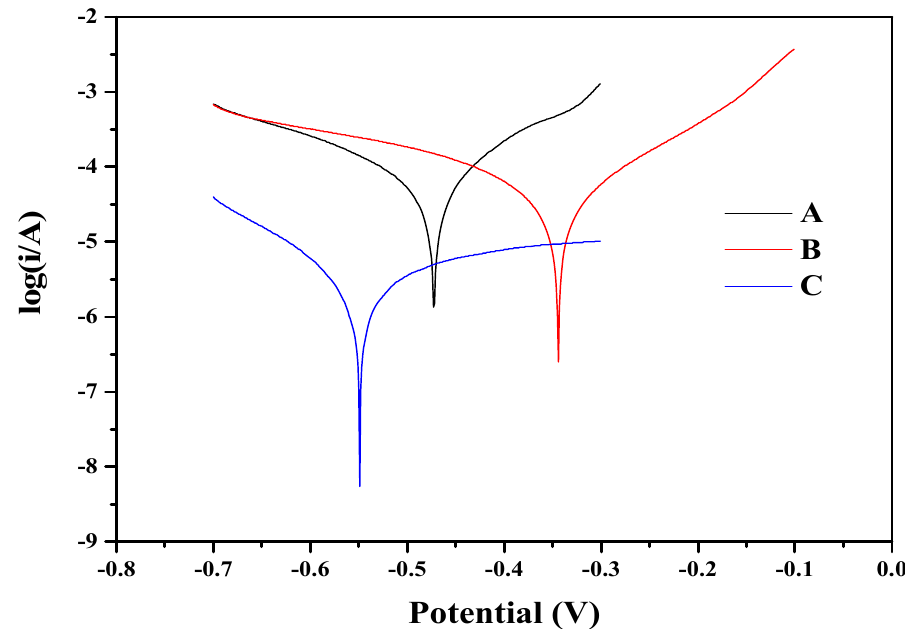
Figure 3. Comparative potentiodynamic polarization curves of the untreated, deposited and superhydrophobic brass meshes. Symbols A, B and C stand for the untreated, electrodeposited and superhydrophobic brass mesh, respectively.